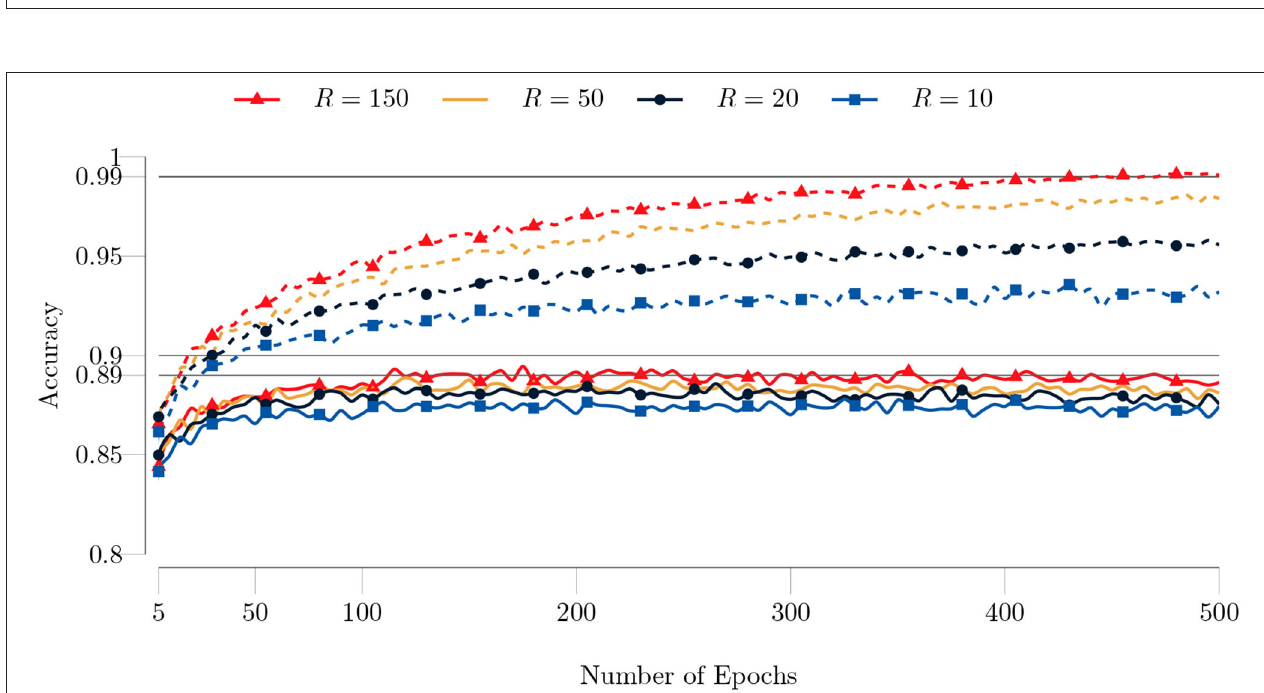
FIGURE 14 | Test (solid lines) and training (dashed lines) accuracies of the type I model for the MNIST dataset with respect to the number of epochs. The full training set (60,000 images) and test set (10,000 images) are used. The batch size is set to 200 and the maximum number of GN iterations is set to 1. Both the test and training accuracy increase as the rank increases. Also the improvement in the accuracy gets smaller as the rank increases. The algorithm achieves around 99 % training accuracy after 400 epochs.